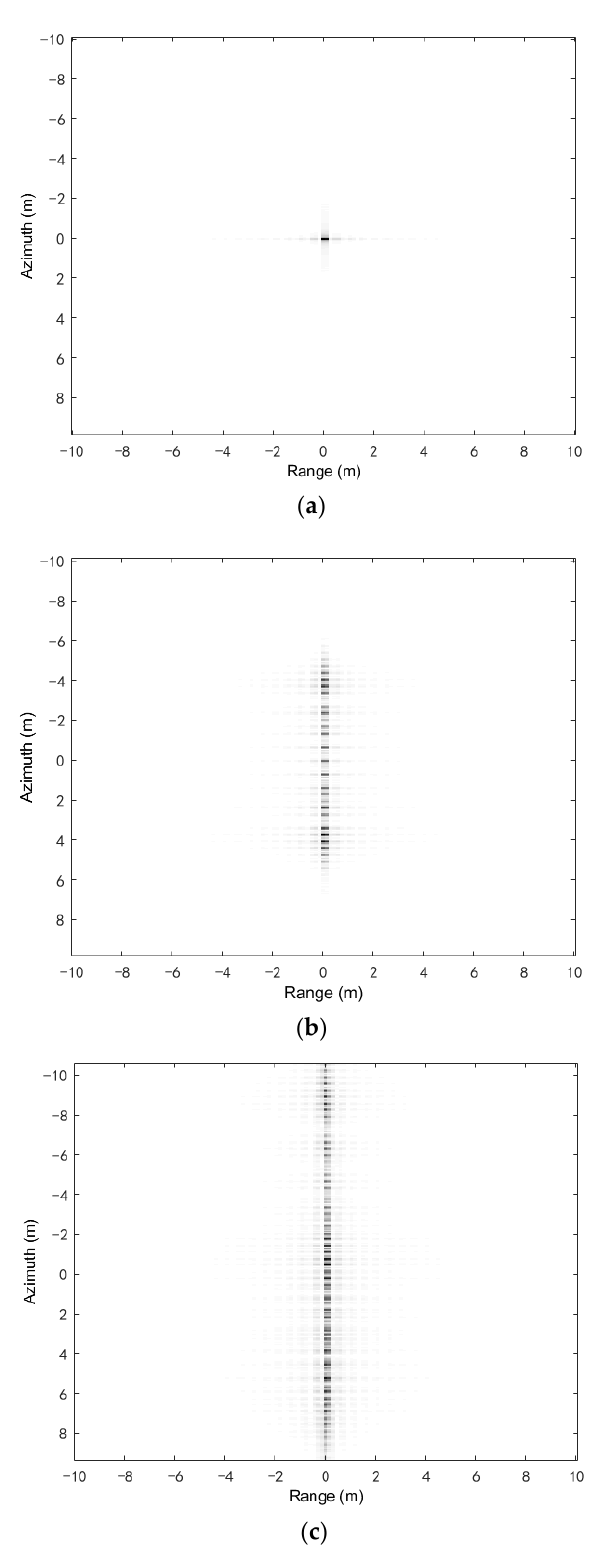
Figure 4. Single point target imaging results. ( a ) Without vibration; ( b ) simple harmonic vibration; ( c ) multi-component sinusoidal vibration.